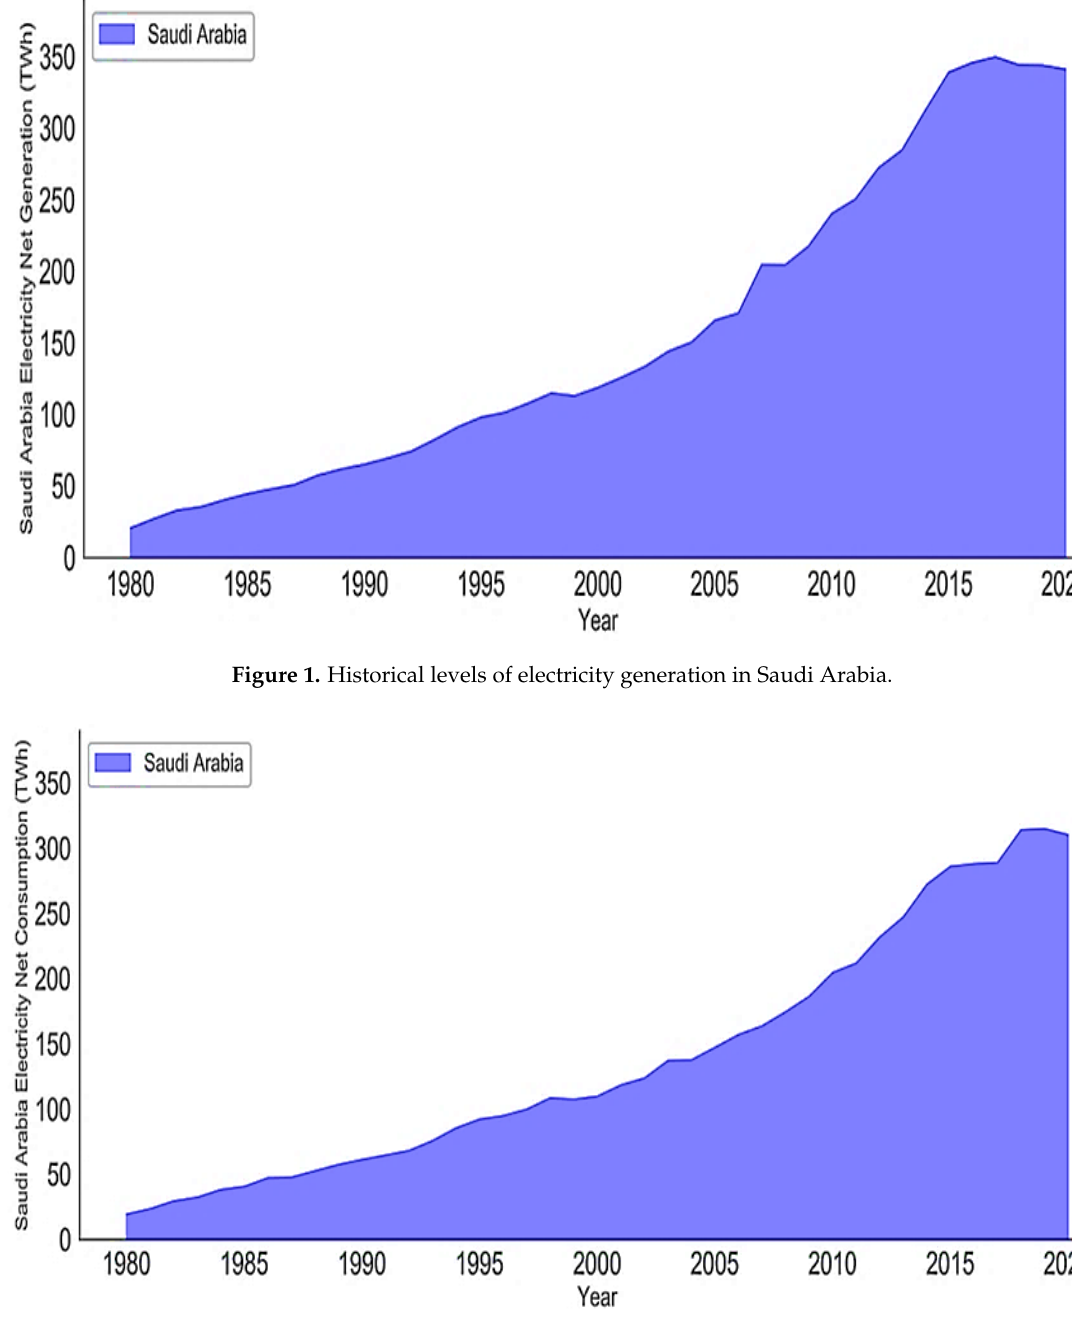
Figure 2. Historical levels of electricity consumption in Saudi Arabia.